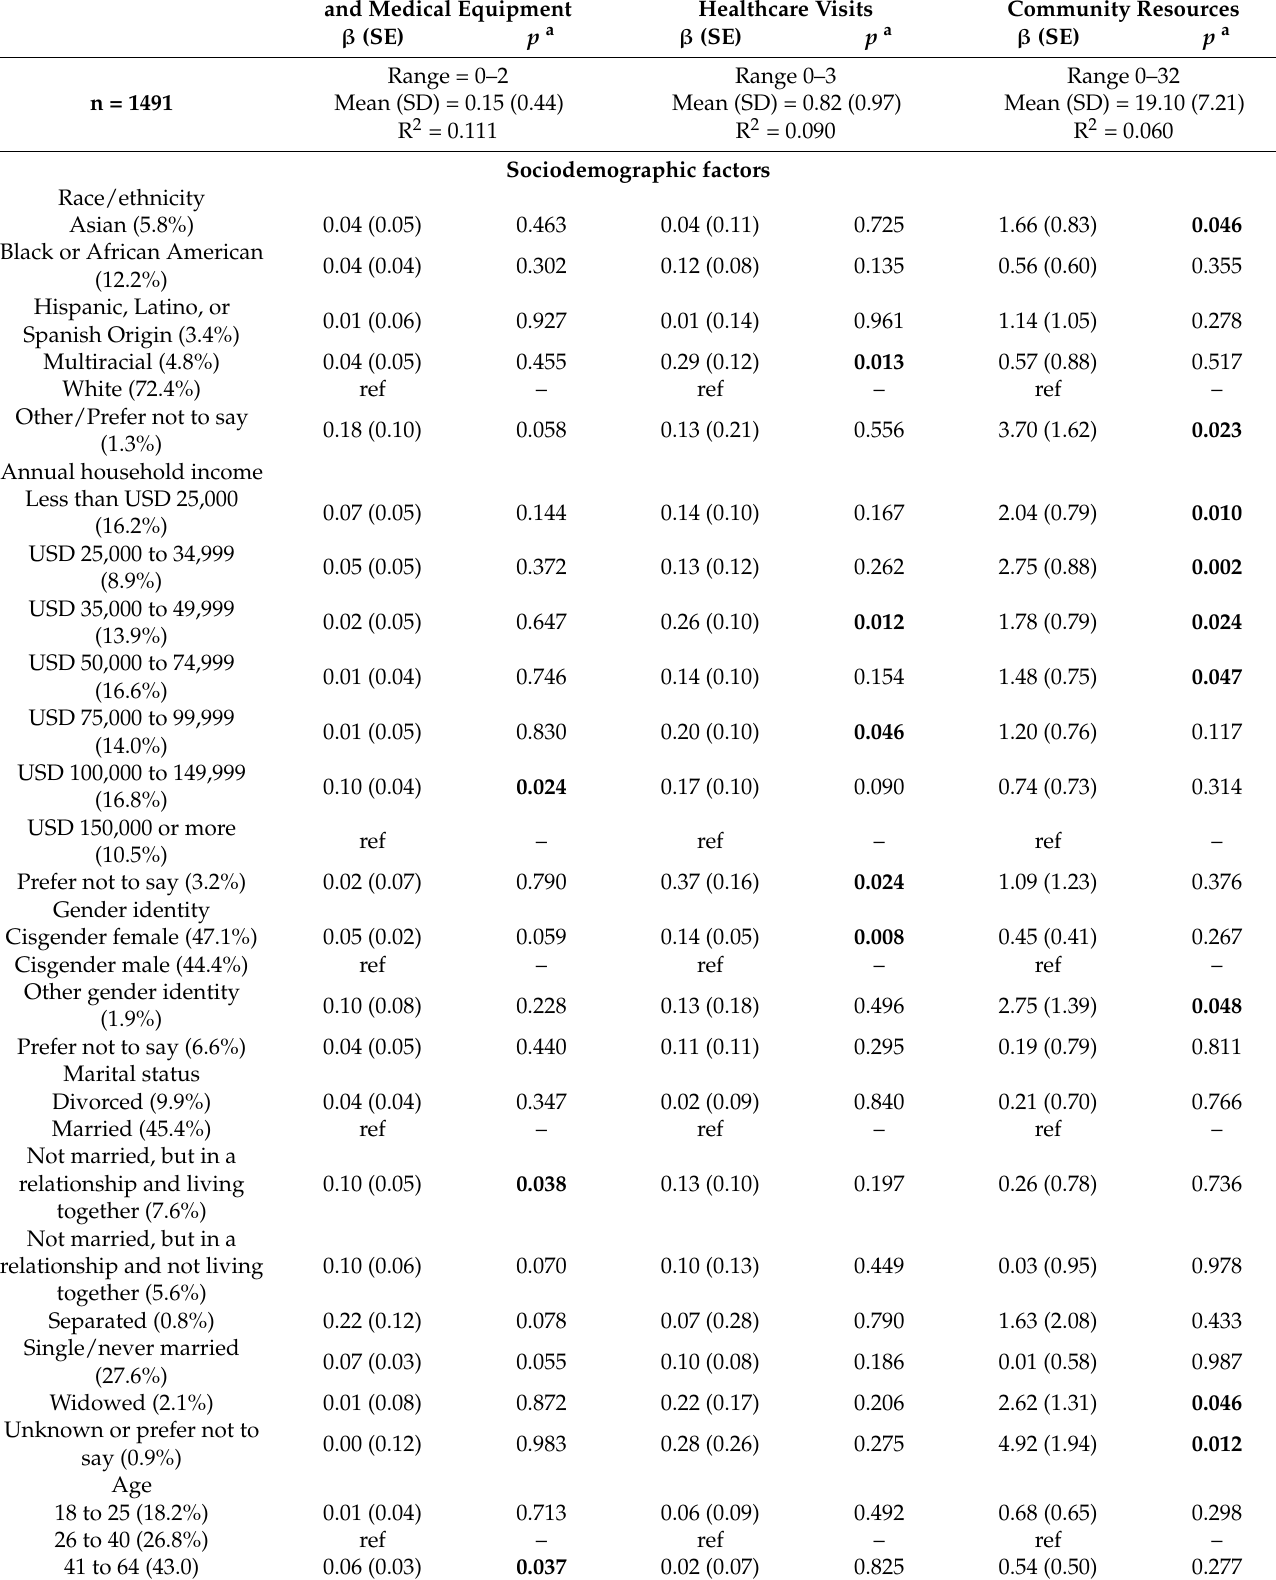
Table 3. Sociodemographic- and health-related correlates of access to health